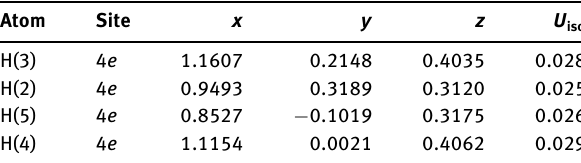
Table 2: Fractional atomic coordinates and isotropic or equivalent isotropic displacement parameters (Å 2